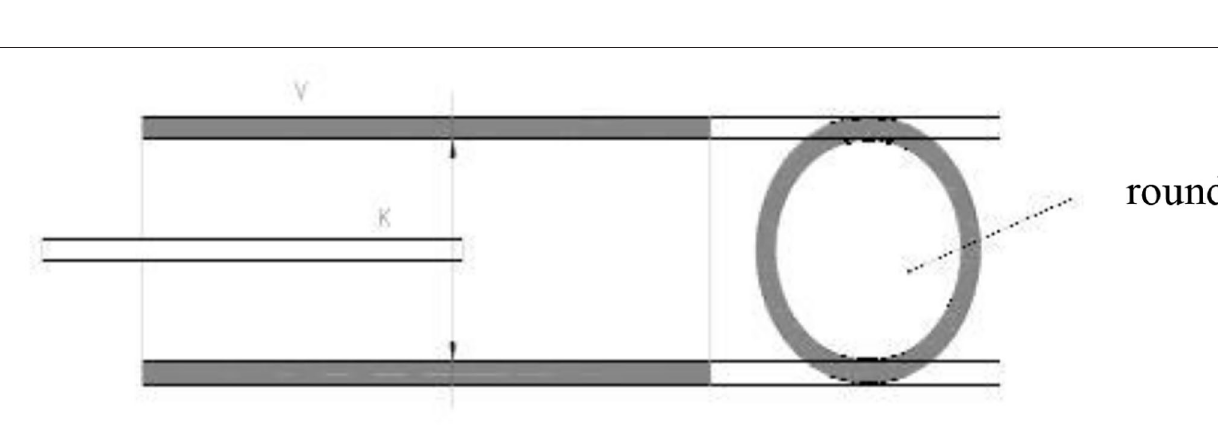
FIGURE 2 | Comparison of normal coronary artery and diseased coronary artery.